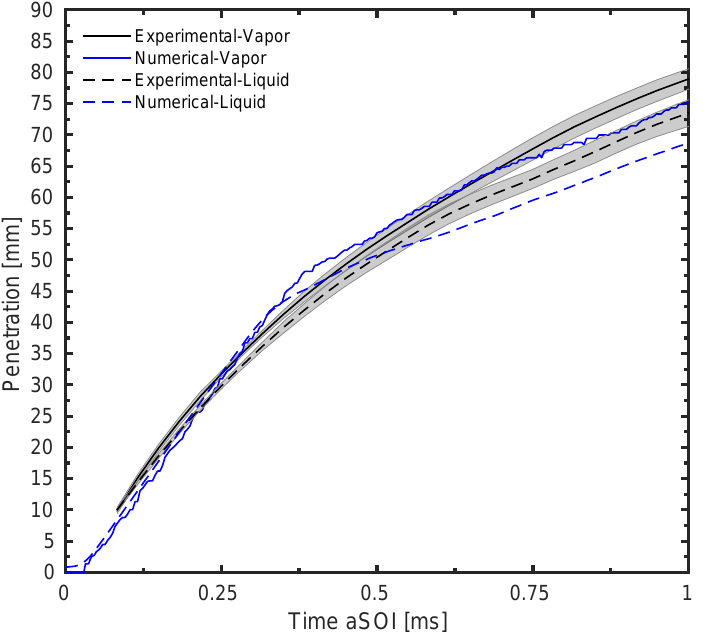
Figure 12. Numerical and experimental axial vapor phases penetration for the G2 cold condition for